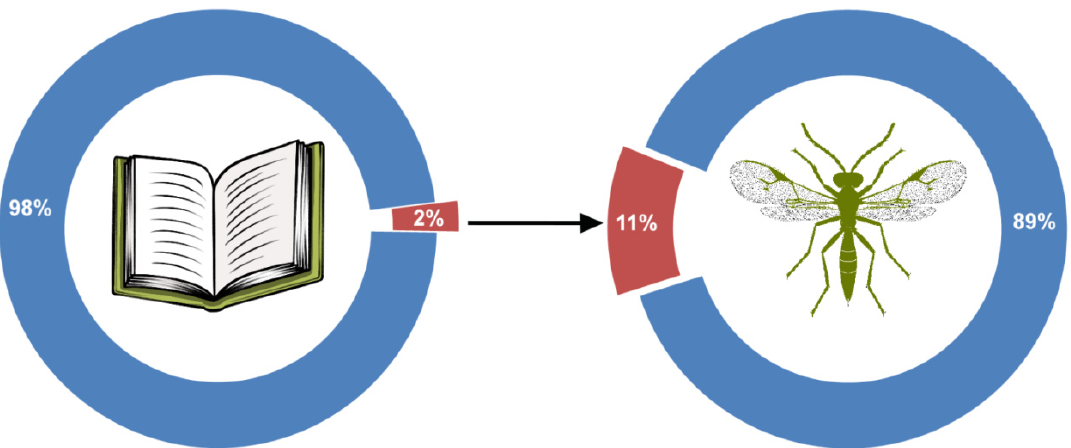
Figure 2. Share of taxonomic papers (red) in Aphidiinae studies conducted in the period 2010–2021 (left) and share of new Aphidiinae species described in the same period (red) compared to the total number of Aphidiinae species (right).